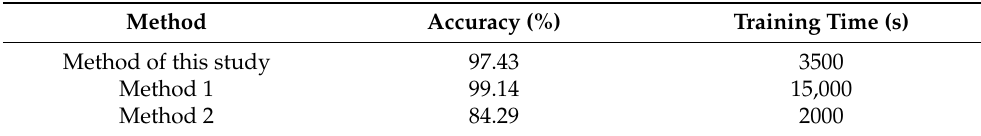
Table 3. Diagnostic results of different